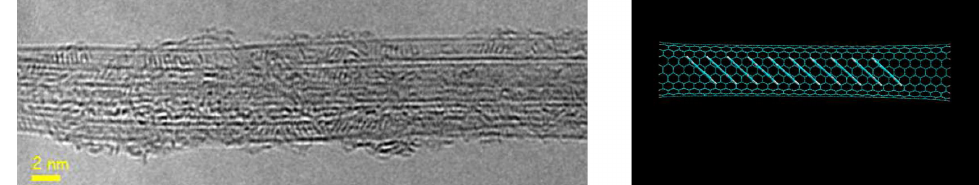
FIG. 3. The HRTEM image of coronene (C 24 H 12 ) stacks inside SWNTs (left panel) and a computer modeling [21] of stacking (right